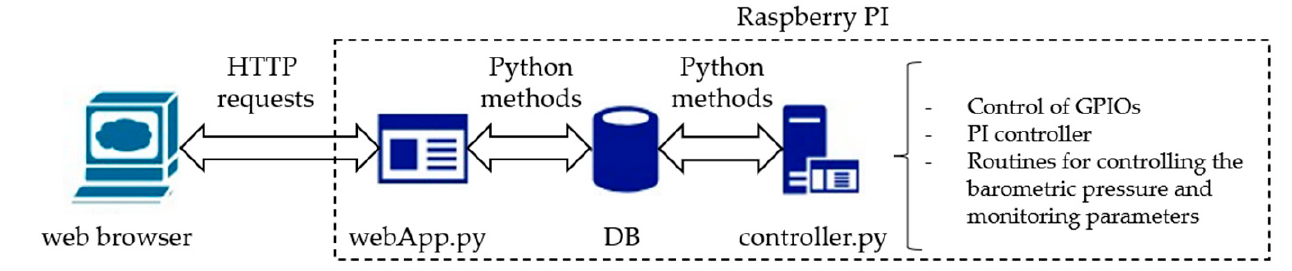
Figure 5. Application architecture developed to automate the control and monitoring routines of the pressure chamber.